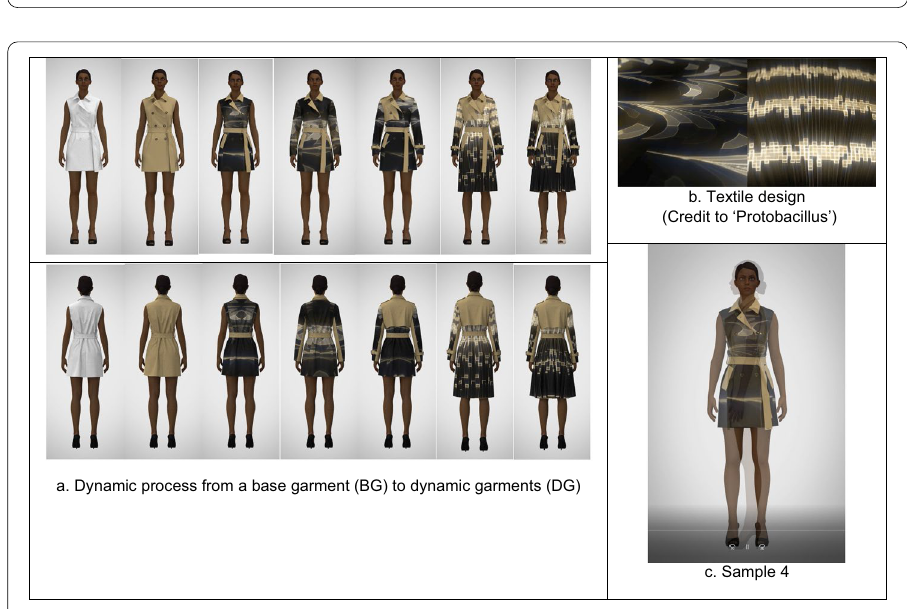
Fig. 4 The technical process to develop a 3D dynamic fashion garment (sample 4): a The moving images, b textile design (GIF), and c sample 4 (MP4) are available in Additional file